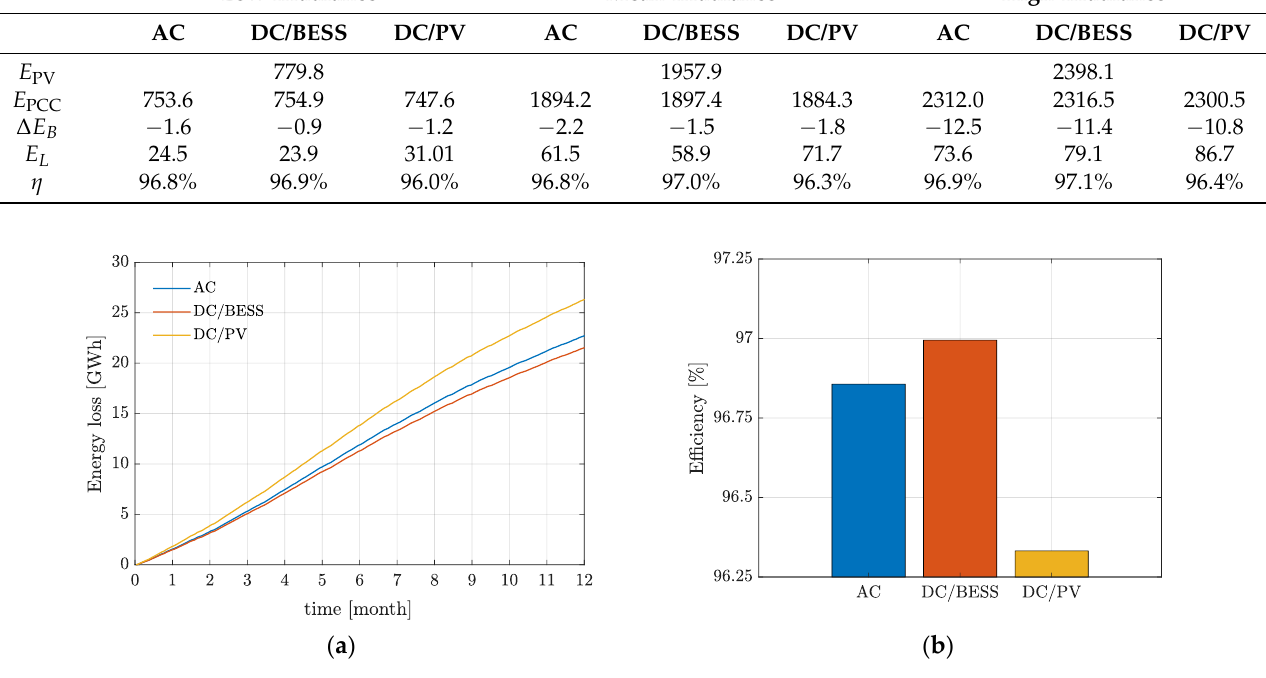
Figure 12. Comparison of total energy losses in one year ( a ) and annual efficiency ( b ) for the three different layouts.